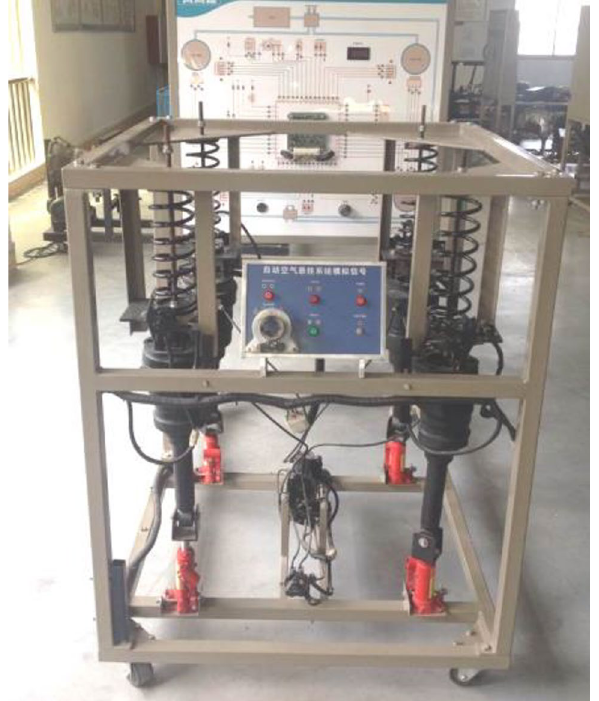
Fig. 1 Test Bench of Active Suspension System